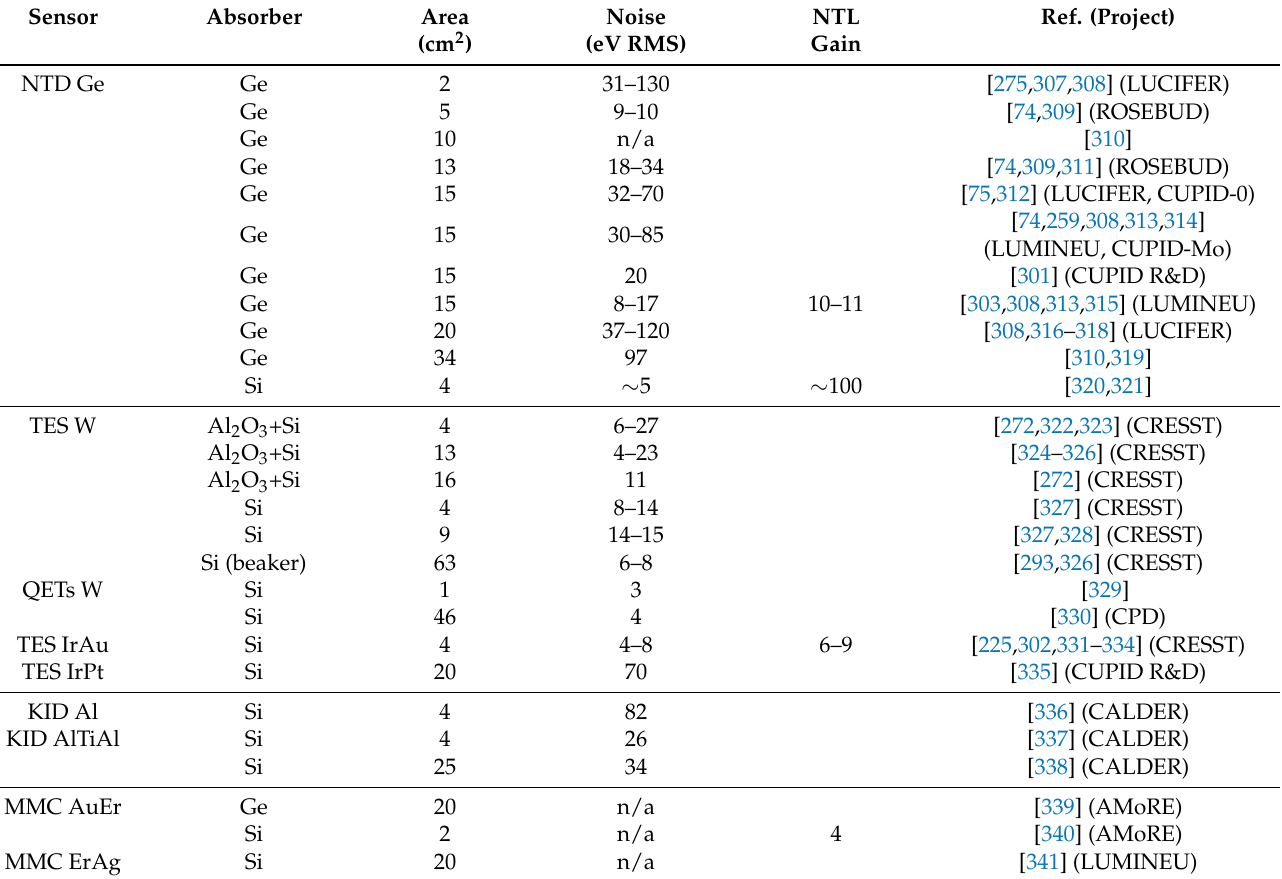
Table 2. Technologies of bolometric photodetectors and representative baseline noise resolution (RMS). The Neganov- Trofimov-Luke (NTL) gain of a signal-to-noise ratio is given only for technologies exploiting the signal amplification based on the NTL effect [305,306]. The transition-edge sensor (TES) technology-based QETs stands for quasiparticle- trap-assisted electrothermal feedback transition-edge sensors (each QET consists of a W TES and an Al fin.). NTD, KID, and MMC stand for neutron-transmutation-doped semiconductors, kinetic inductance detector, and metallic magnetic calorimeter,